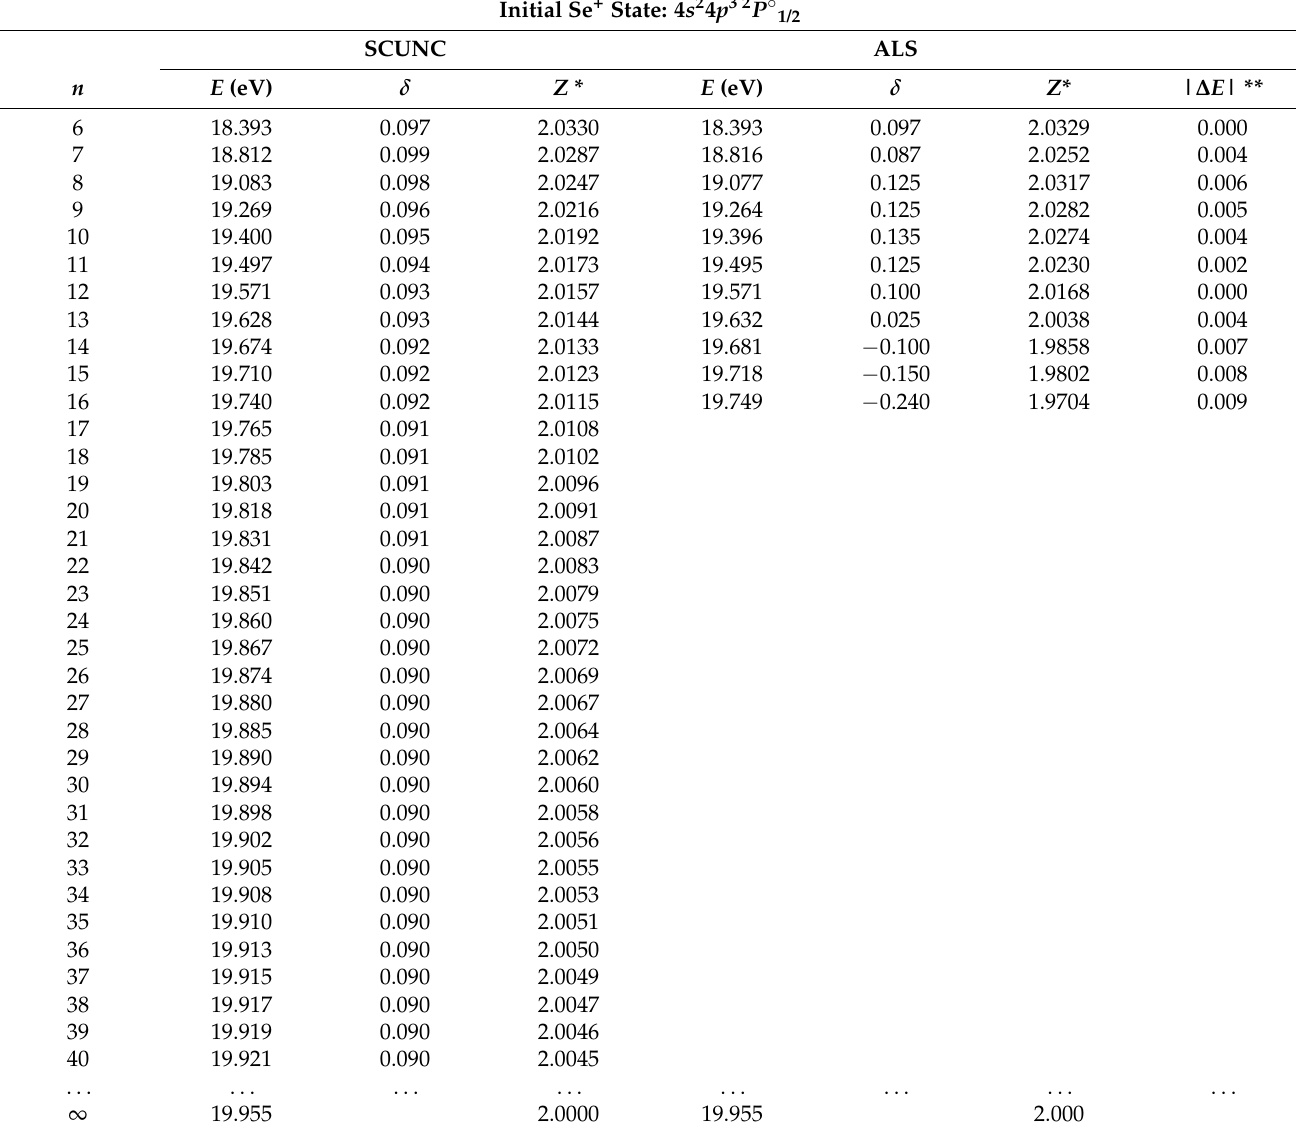
Table 6. Energy resonances ( E ), quantum defect ( δ ) and effective charge ( Z *) of the 4 s 2 4 p 2 ( 1 D 2 ) nd ( 2 S ) Rydberg series originating from the 4 s 2 4 p 3 2 P ◦ 1/2 metastable state of Se + converging to the 3 P 2 series limit in Se 2+ . The present results (SCUNC) are compared with the experimental data from ALS measurements [6]. The uncertainties in the experimental energies are stated to be ± 0.010 eV, f 1 ( 1 D 2 ;